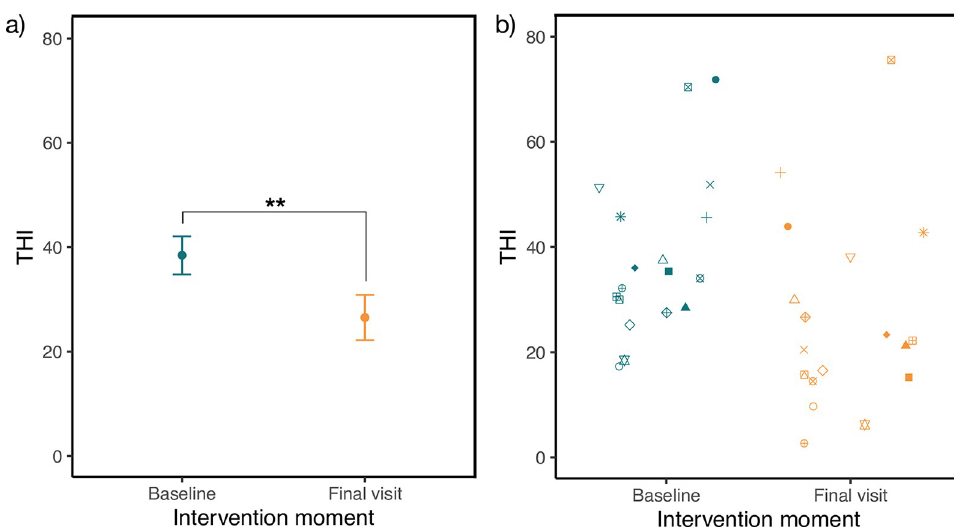
Fig 2. Improvement of THI from begin of baseline phase to final visit. a) Significant improvement of Tinnitus Handicap Inventory (THI) score from the begin of baseline phase to final visit of the sample. Higher scores indicate higher handicap. Dots represent means, error bars are standard errors; �� p < .001; N = 18. b) Individual THI values at baseline and final visit. The same shape represents the same individual.